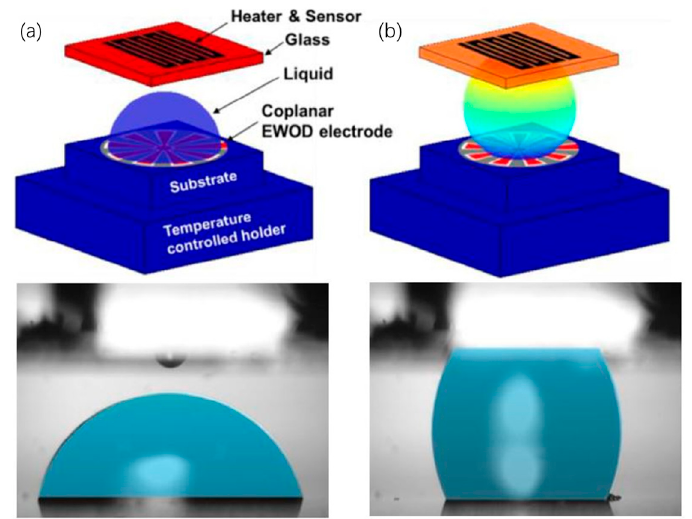
Figure 4. Thermal conductance switching based on the actuation of liquid droplets through EWOD principle with the thermal switch in the off ( a ) and on ( b ) states. Reproduced with permission from [48]; published by ELSEVIER, 2016.